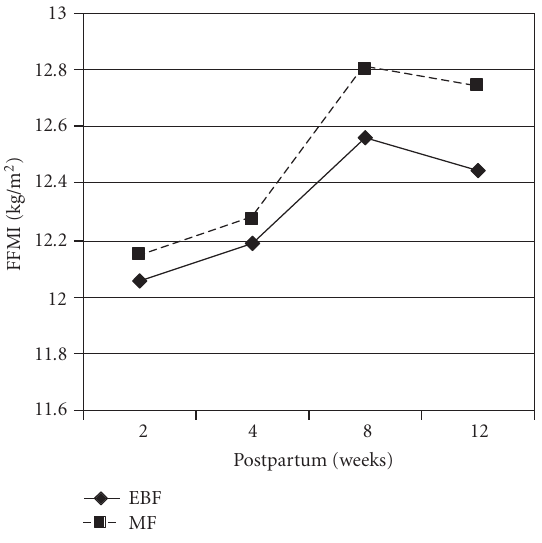
Figure 3: Pattern of infant lean mass with time ( EBF: exclusive breastfeeding; MF: mixed